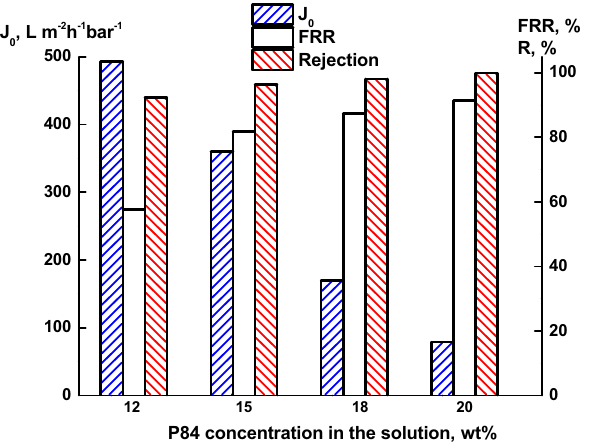
Figure 2. Dependence of the pure water flux ( J 0 ), rejection ( R ) and the flux recovery ratio ( FRR ) of P84 membranes on the P84 concentration in the casting